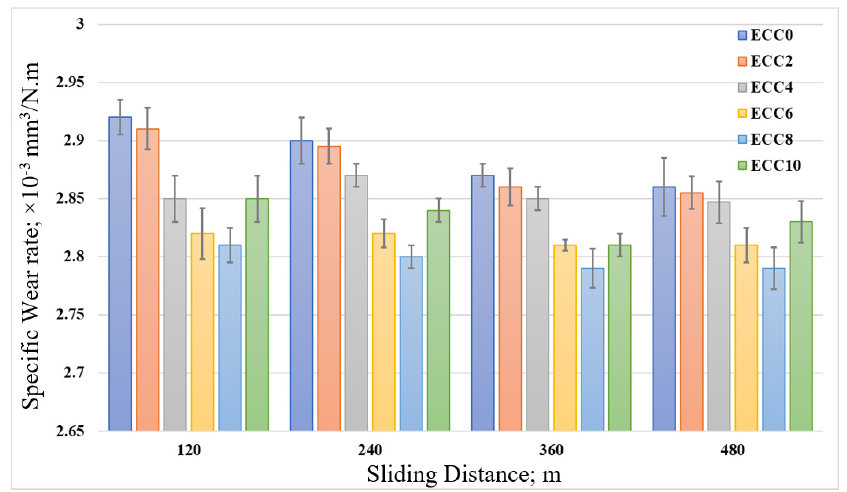
Figure 13. The specific wear rate of epoxy/corn cob composites with different sliding distances.